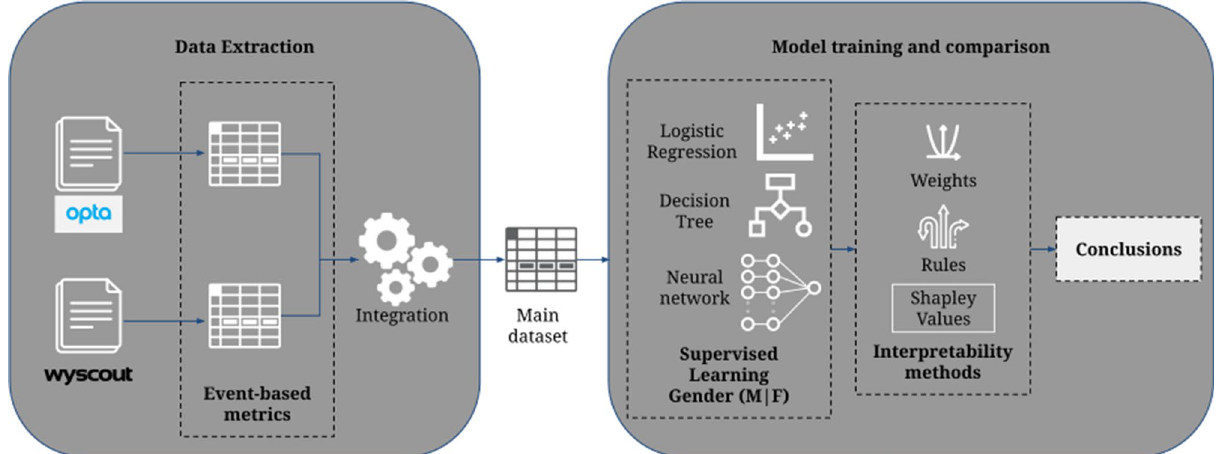
Figure 1. Complete methodology. We obtained event-based metrics from the two different data sources and integrated them into a single dataset. We implemented three supervised learning models and analyzed interpretability methods to understand the models.